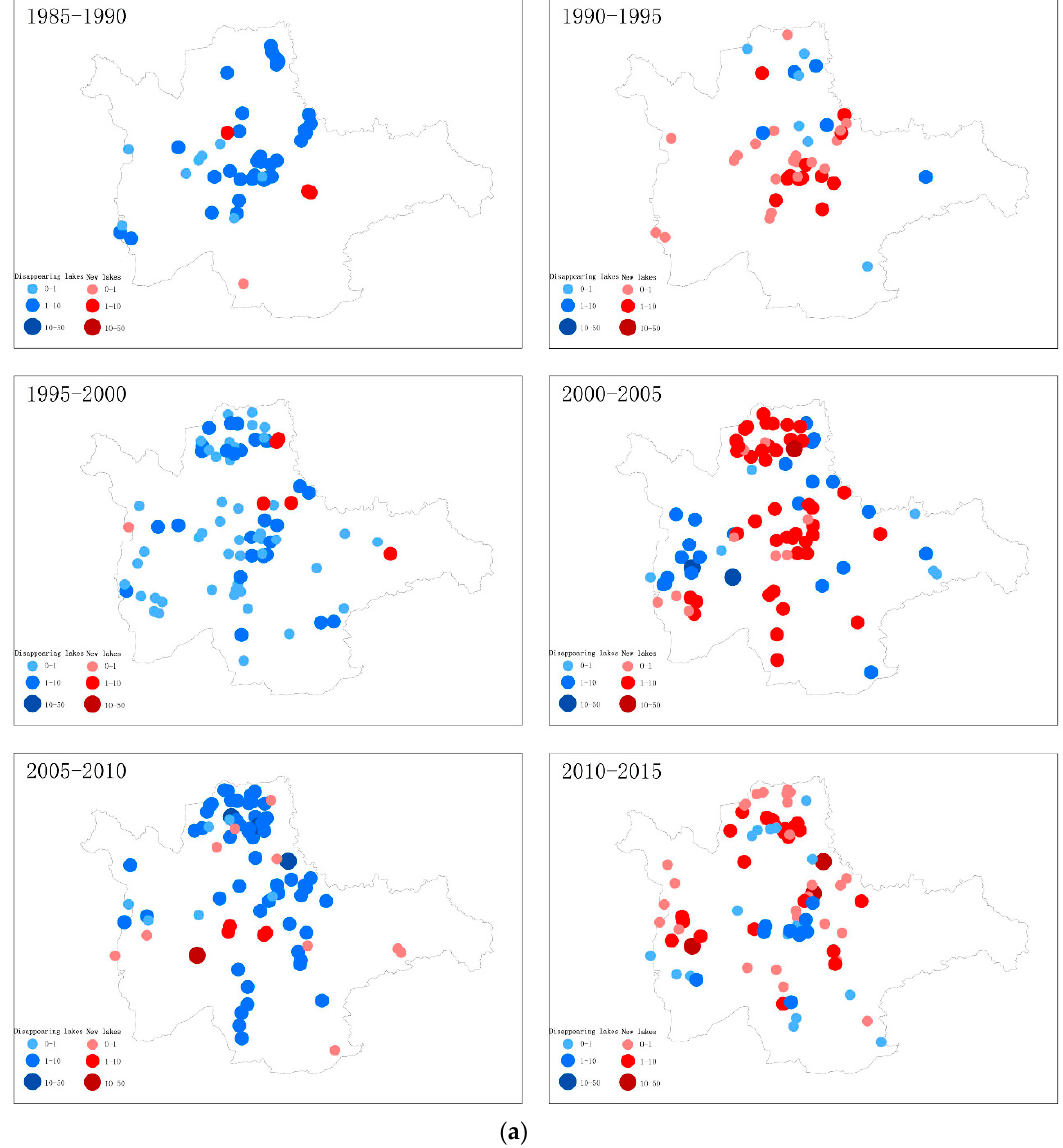
Figure 4. ( a ) The spatial location of newly added and disappeared lakes every five years from 1985 to 2015. New and disappeared lakes are also classified according to di ff erent area levels (area less than 1 km 2 , 1 to 10 km 2 and 10 to 50 km 2 , respectively); ( b ) The cluster analysis of the newly added and disappeared lakes in ( a ) shows that there are clusters in 1985–1990 and